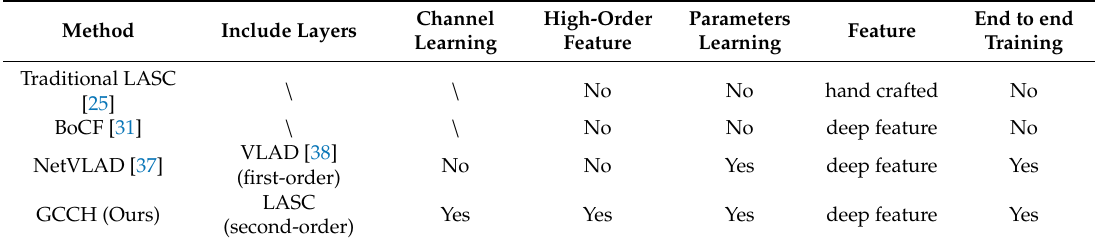
Table 1. The di ff erences between the proposed GCCH network and other